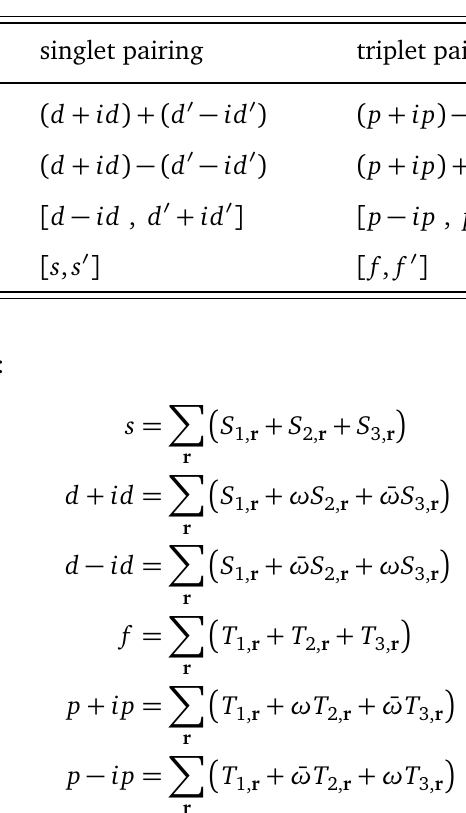
Table 2: Irreducible representations (irreps) of D operators defined on nearest-neighbor sites, as defined in Eqs (2). (Un)primed op- erators belong to the second (first)